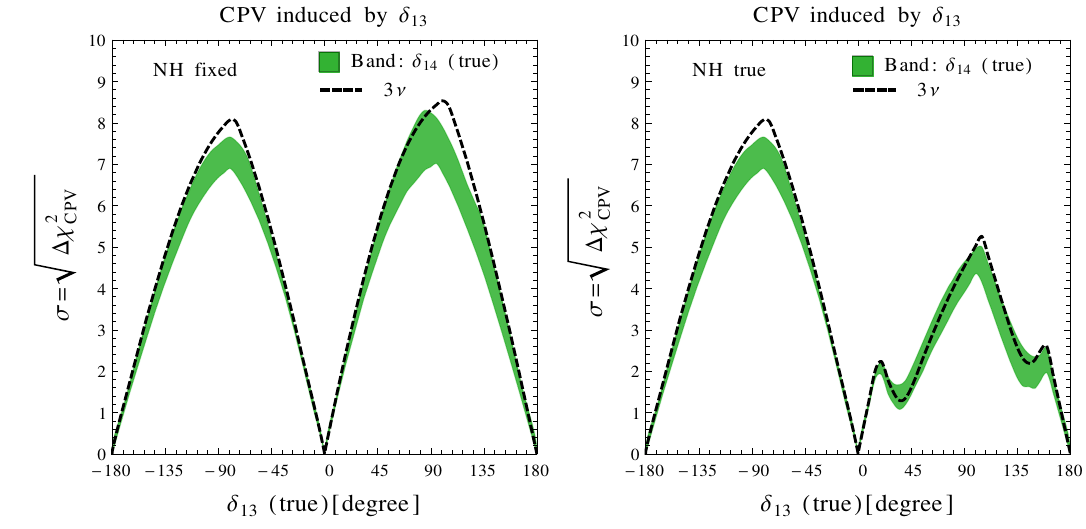
Figure 4 . T2HK discovery potential of (cid:14) 13 6 = (0 ; (cid:25) ). In the left panel the MH is (cid:12)xed to be the NH (both true and test value). In the right panel the MH is marginalized with NH true. In both panels, the black dashed curve corresponds to the 3-(cid:13)avor case. In 3+1 scenario, we (cid:12)x the true and test values of (cid:18) 14 = (cid:18) 24 = 9 0 . In both panels, the colored bands are obtained in the 3+1 scheme by varying the unknown value of the true (cid:14) 14 in its entire range of [ (cid:0) (cid:25); (cid:25) ] while marginalizing over test (cid:14) 14 in the same range.